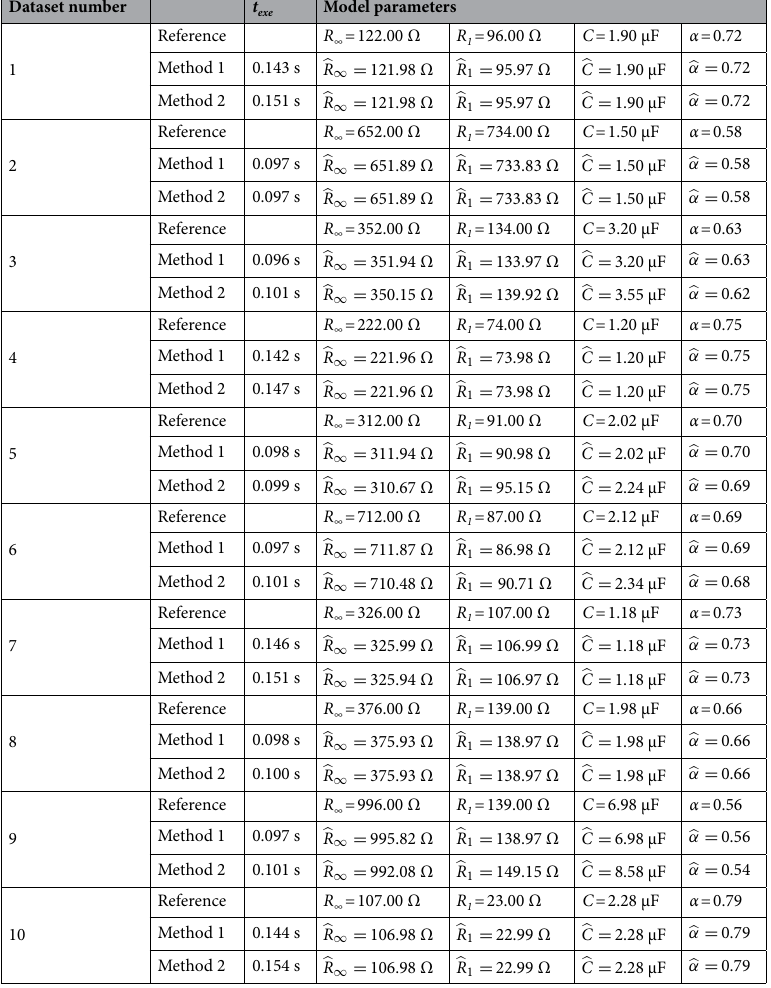
Table 1. Performance comparison of the proposed method in case of data with 1% of